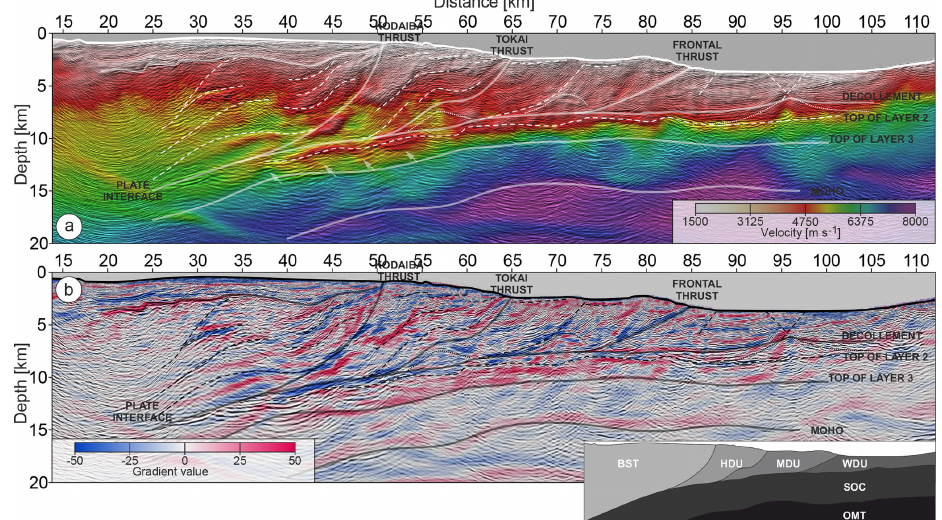
Figure 11. Imaging results and structural interpretation. Migrated section superimposed on the following: (a) the FWI velocity model blended with the average vertical and horizontal velocity gradient; and (b) the average vertical and horizontal velocity gradient of the FWI model. Inset presents different geological block segments: OMT – oceanic mantle; SOC – subducting oceanic crust; WDU – weakly deformed unit; MDU – moderately deformed unit; HDU – heavily deformed unit; BST – backstop.